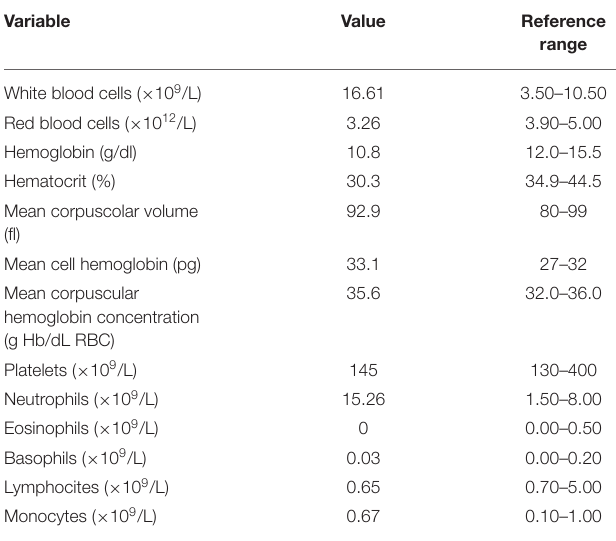
FIGURE 1 | Pulmonary computed-tomographic (CT) performed on January 26th, 2020: bilateral confluent and patchy ground-glass and consolidative pulmonary opacities, small, bilateral pleural